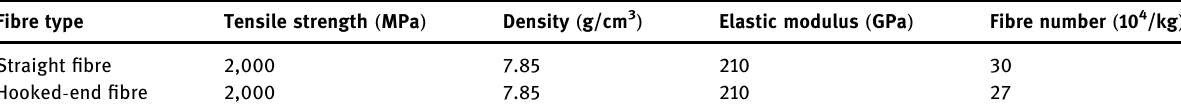
Table 4: Properties of the steel fi bres Fibre type